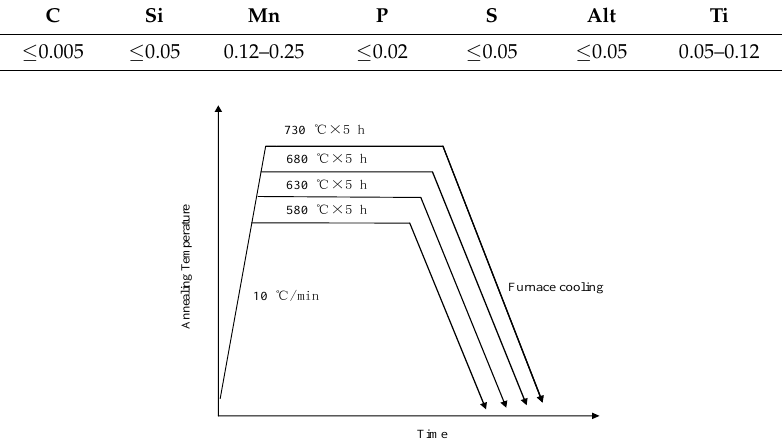
Table 1. Chemical composition of experimental steel (in wt %).